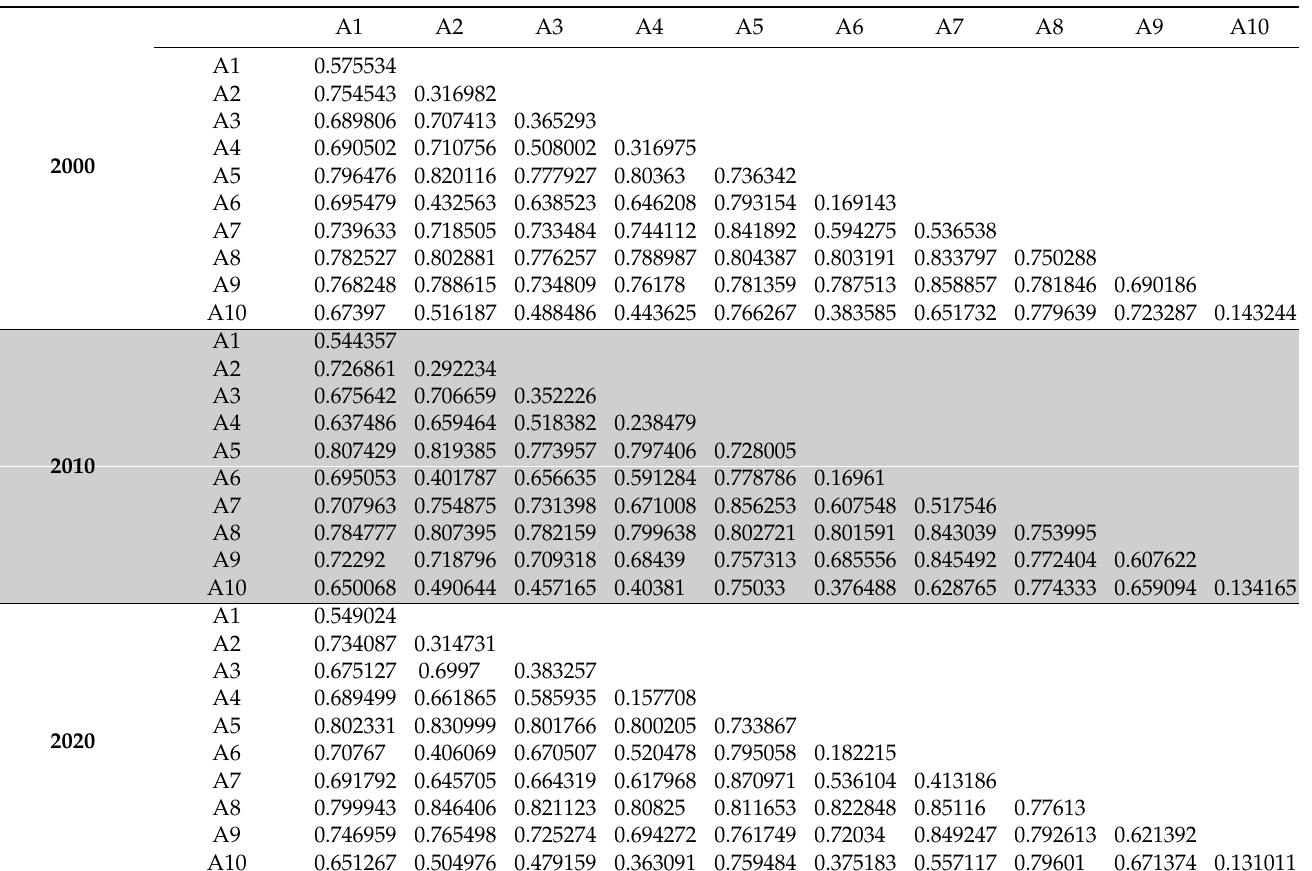
Table 5. Results of interaction detection of spatially divergent drivers of ES supply-demand in resource-based cities in the